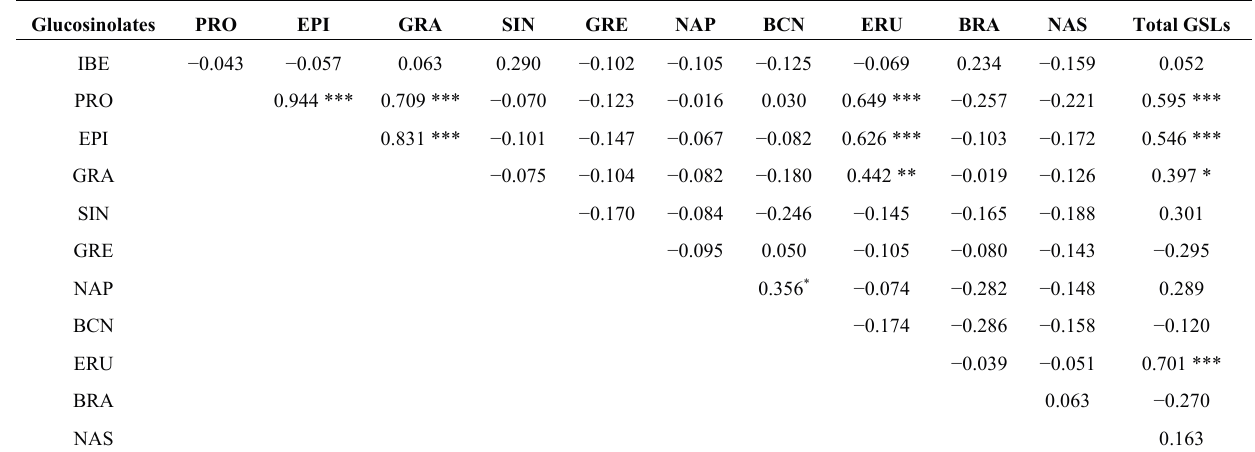
Table 6. Overall correlation coefficients among glucosinolates identified in nine Brassica